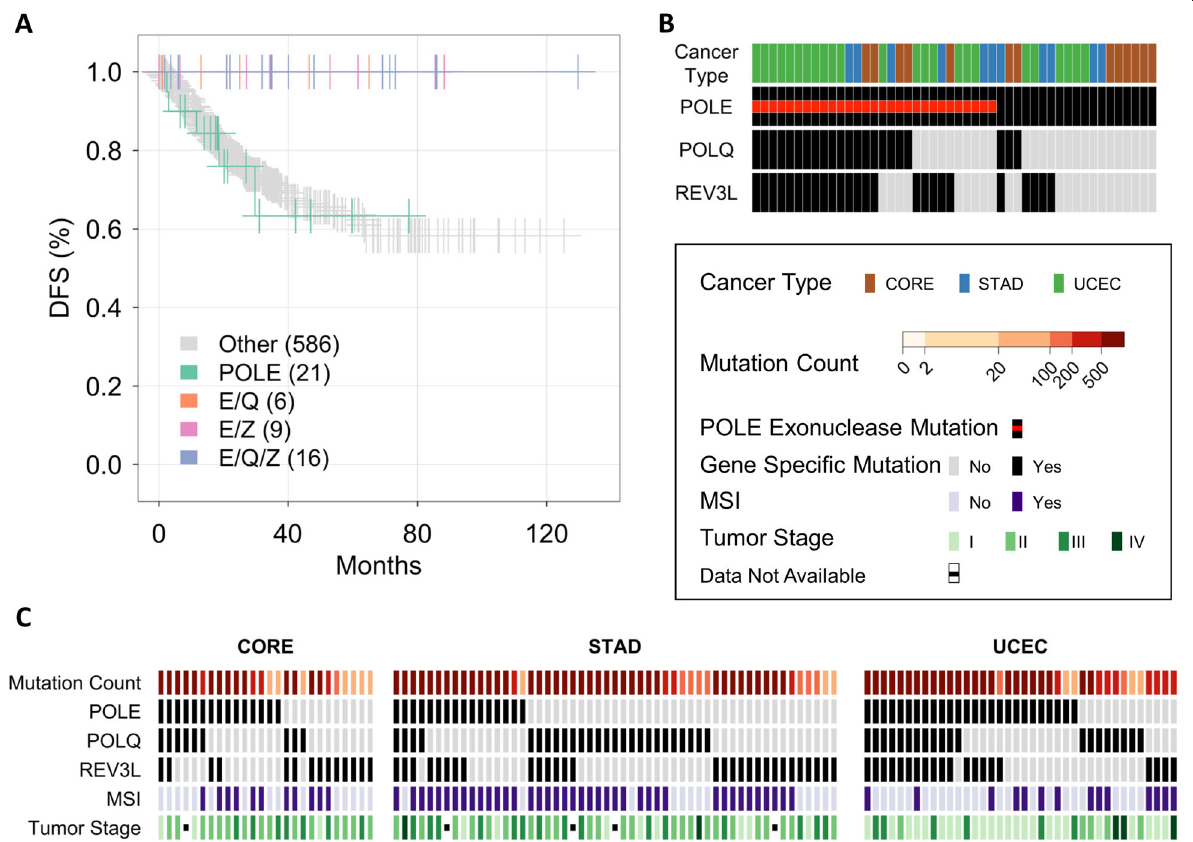
Fig. 3 Survival and clinical characteristics of patients with polymerase mutations colorectal [38] , endometrial (UCEC) and stomach (STAD) cancers. a Kaplan-Meier curves of Disease-Free Survival (DFS) for 3 groups of patients: POLE only ( n = 21, median follow-up =18.4 months), green line; E/Q ( n = 6, median follow-up = 19.0 months), orange line; E/Z ( n = 9, median follow-up = 34.3 months), pink line, and E/Q/Z ( n = 16, median follow- up = 37.5 months), blue line; tumors without mutations in POLE , POLQ or REV3L exomes, grey line. The overall p-value is p = 0.0477. Individual p - values: E/Q/Z vrs. POLE – p = 0.021; E/Q/Z vrs. None – p = 0.018, E/Q or E/Z or E/Q/Z vrs. POLE – p = 0.003. b Polymerase mutation analysis of cases in the good survival group in panel A. The red bar indicates cases with POLE exonuclease mutations. c Cancer type-specific illustration of mutation count, POLE , POLQ and REV3L mutations, microsatellite instability (MSI) and tumor